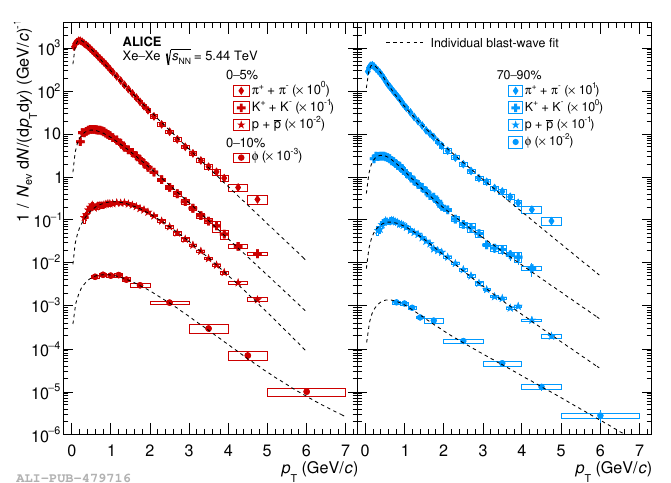
Figure 1. Transverse momentum distributions of π ± , K ± , p , ¯ p and φ as measured in central (left) and peripheral (right) Xe–Xe collisions at √ s NN = 5 . 44